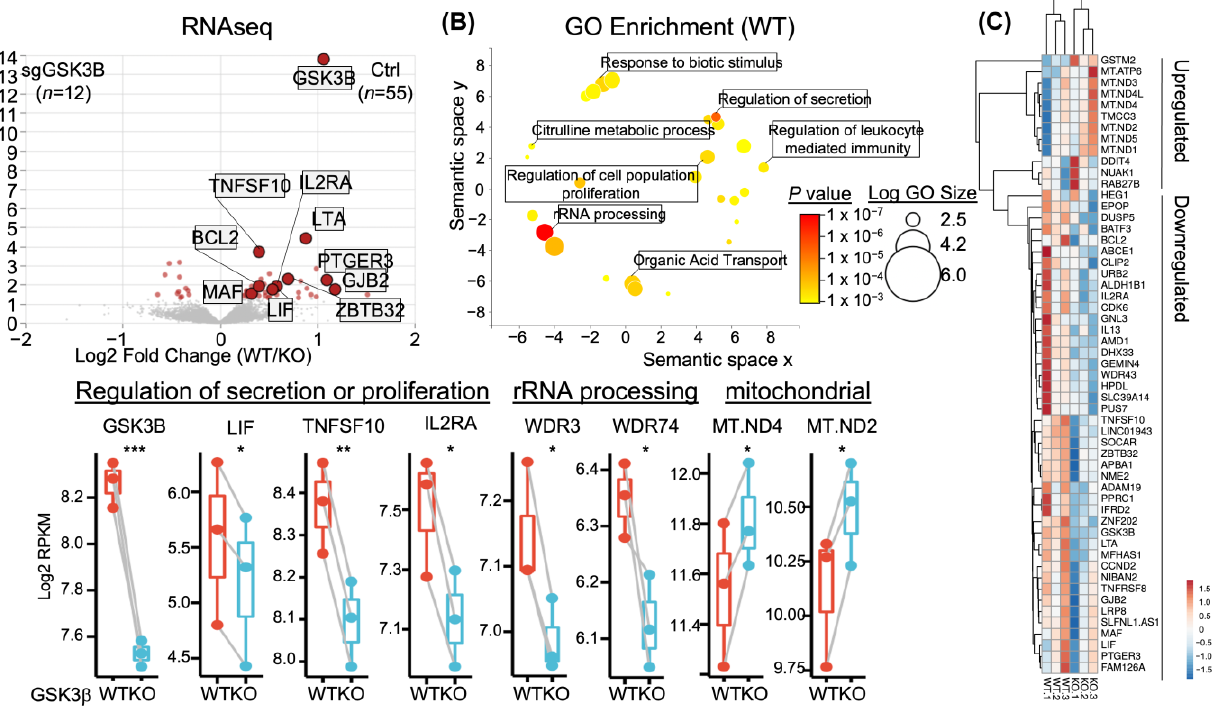
Figure 3. GSK3B -KO in NK resulted in transcriptomic changes, RNA-seq analysis was performed on NK cells from FC-21 expanded WT and GSK3B -KO. ( A ) volcano plot representing DEG (WT/KO). ( B ) GO enrichment (WT). Heatmap ( C ) and RNA-seq boxplots ( D ) showing the top downregulated and top upregulated genes affected by GSK3B deletion. * p ≤ 0.05, ** p ≤ 0.01, *** p ≤ 0.001. For ( C ), rows are centered; unit variance scaling is applied to rows. Both rows and columns are clustered using correlation distance and average linkage.